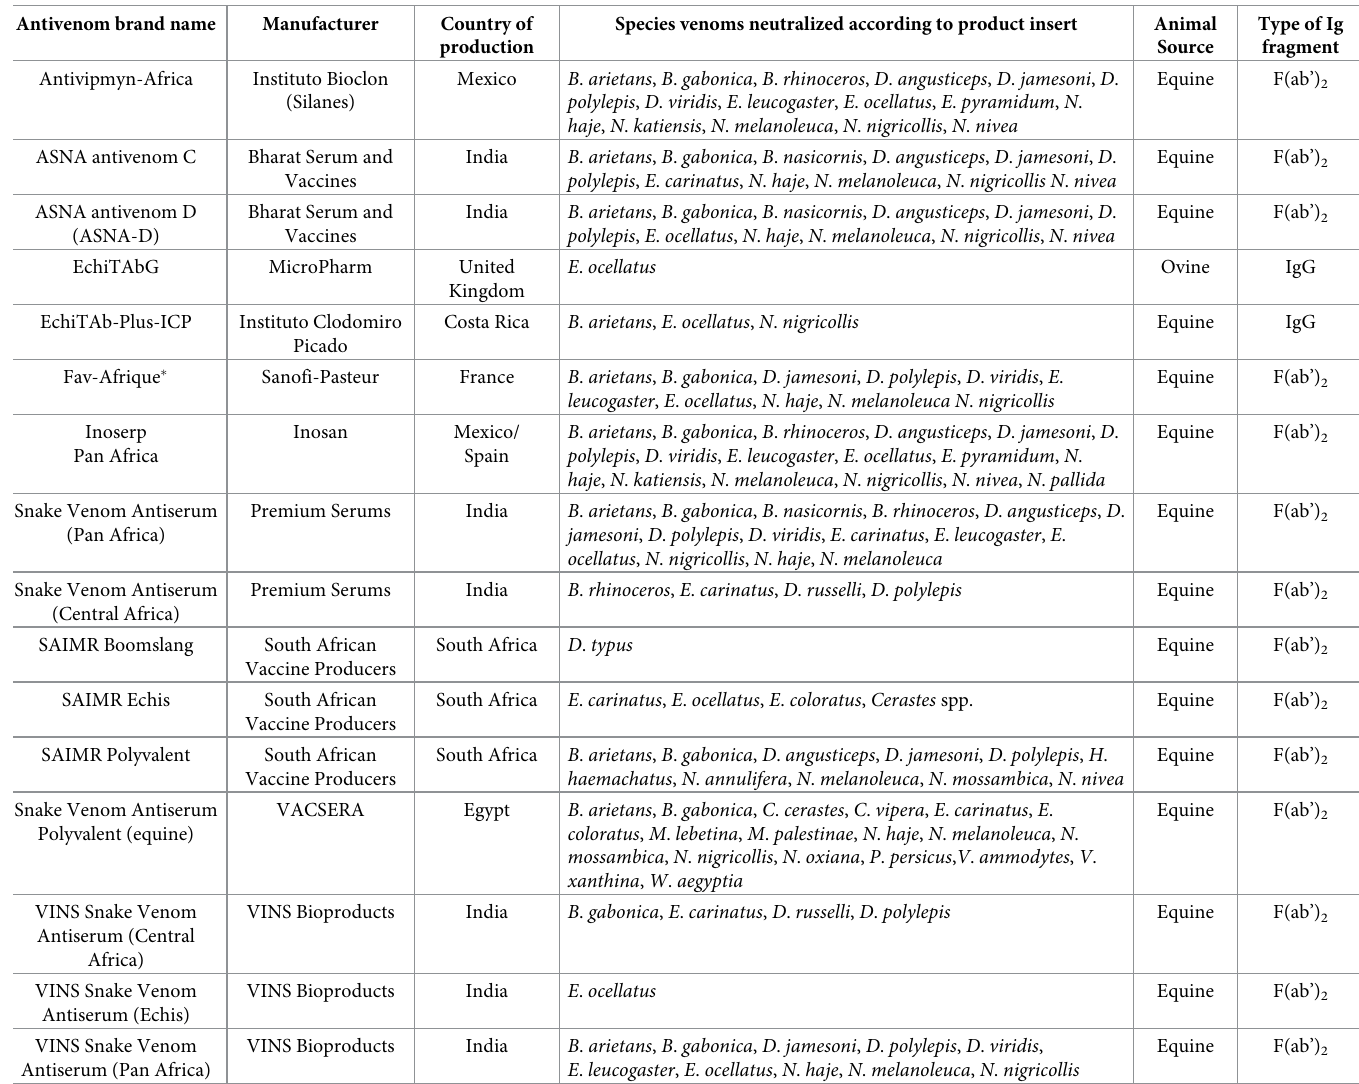
Table 1. Commercially available, or recently available, African antivenom products. This table is based on estimation of available antivenom products by Potet et al. 2019 [11]. � = manufacturing currently on hold. Antivenom brand